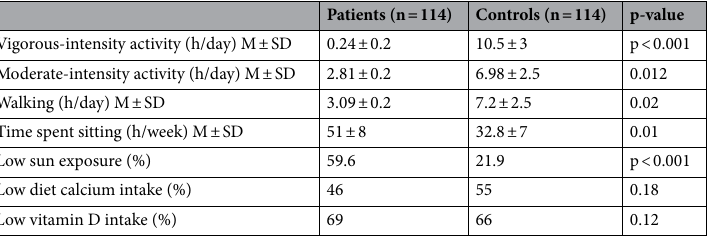
Table 2. Life style results in patients and